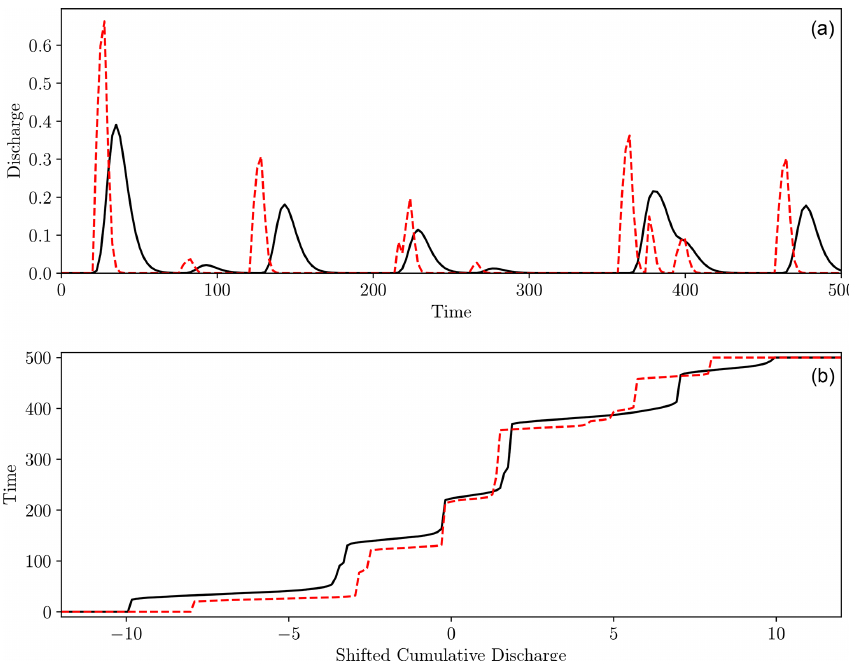
Figure 9. Visual representation of computing the hydrograph–Wasserstein distance. Panel (a) shows two synthetic hydrographs (dashed red and solid black) between which we want to compute the distance. Panel (b) shows the inverse shifted cumulative functions defined in Eqs. (18) and (19). Transport occurs between points vertically aligned in panel (b) , forcing excess mass to be mapped to the